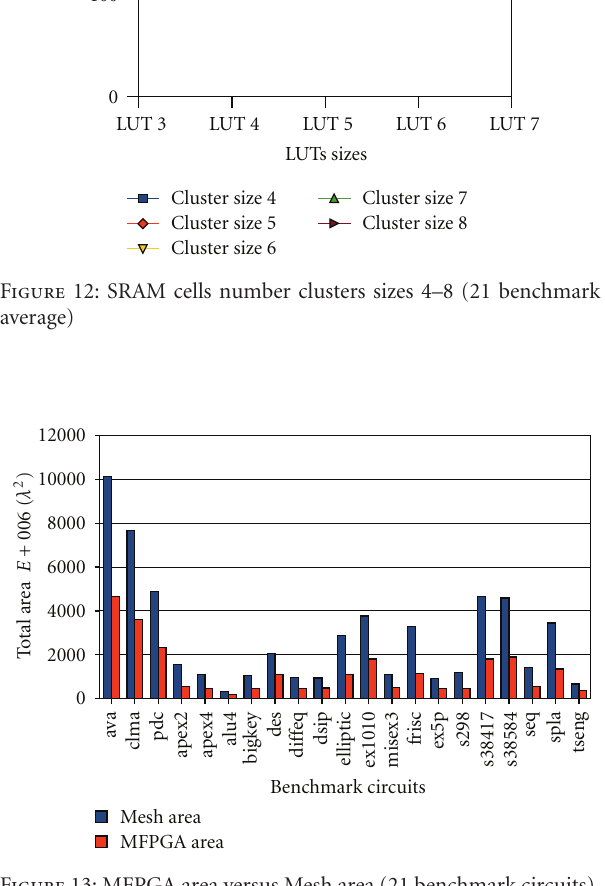
584 LUTs) and 60% with ava (largest circuit 14964 LUTs).